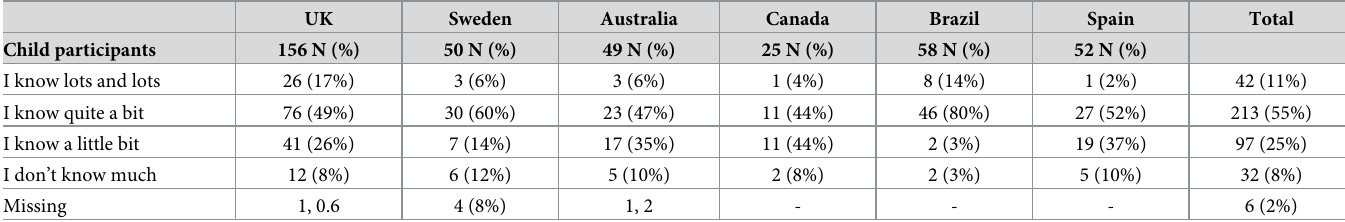
Table 7. Children’s self-report of how much they know about